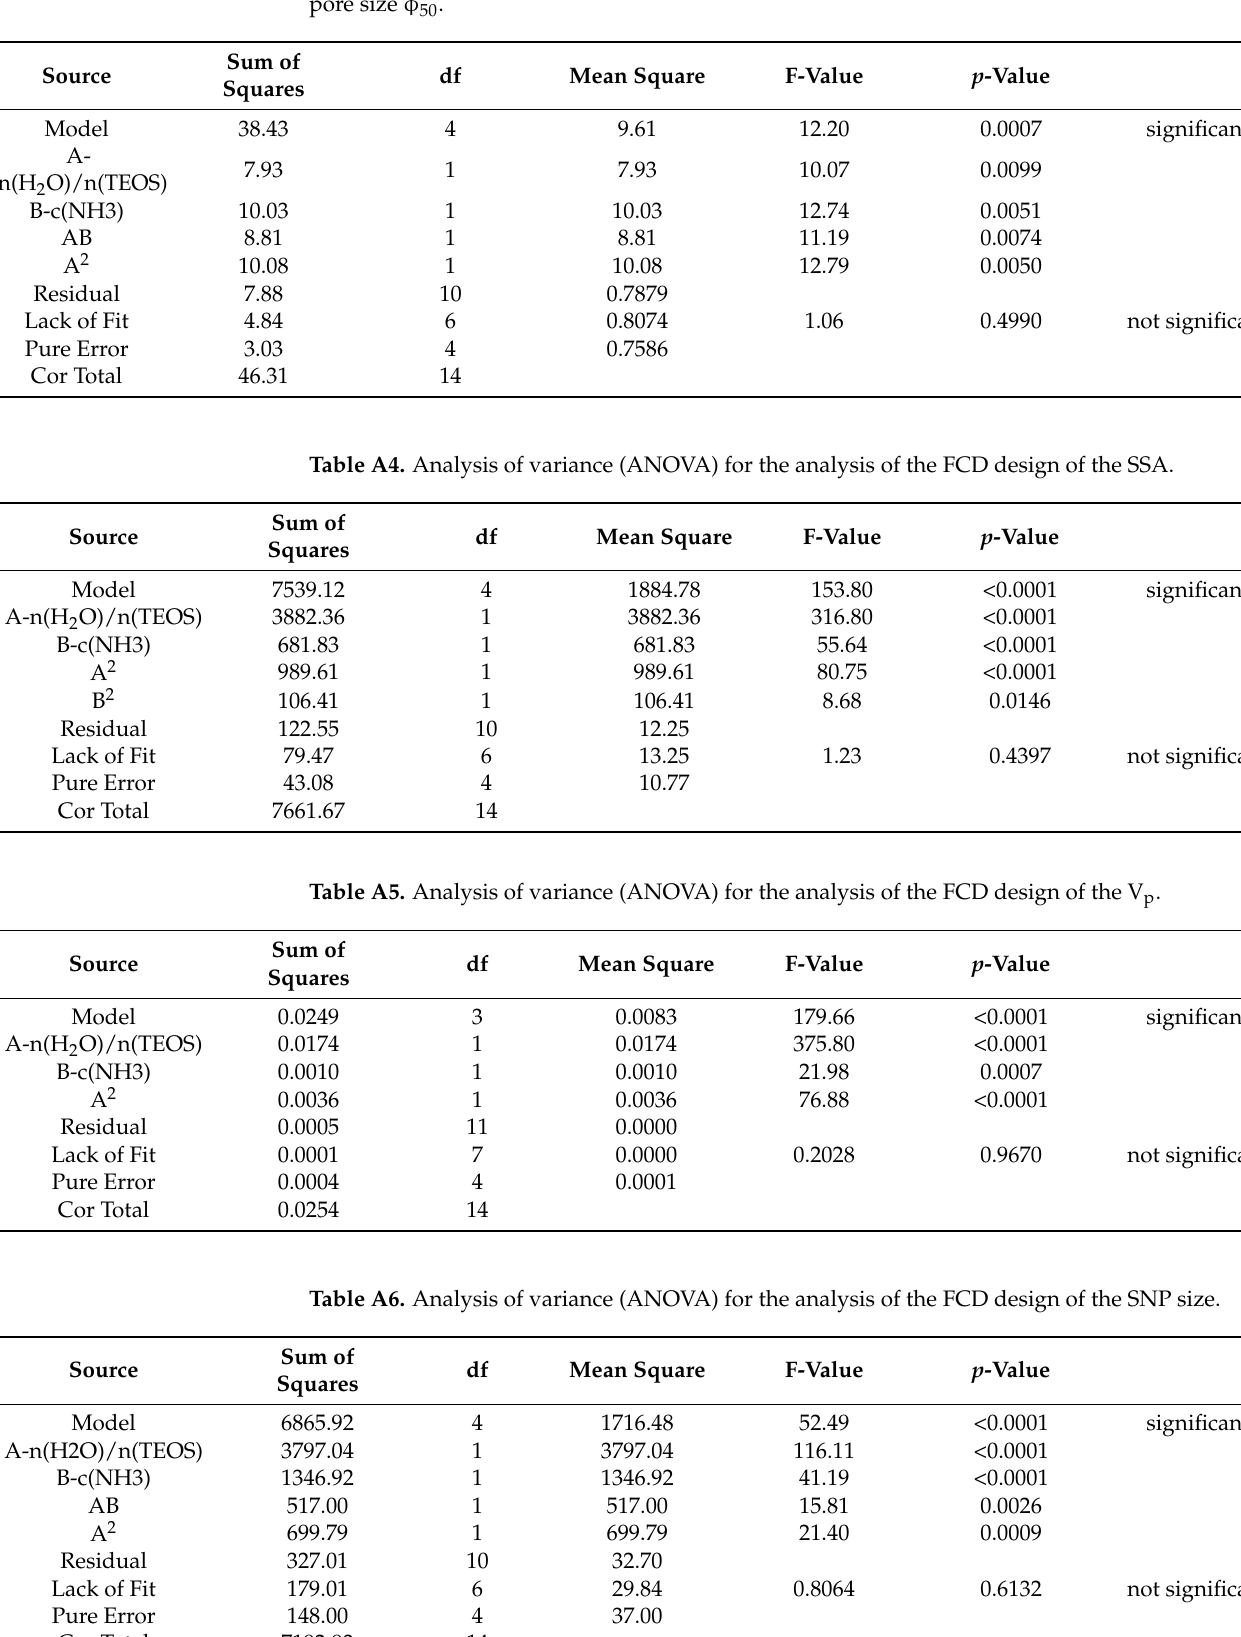
Table A3. Analysis of variance (ANOVA) for the analysis of the FCD design of the median pore size φ 50 .